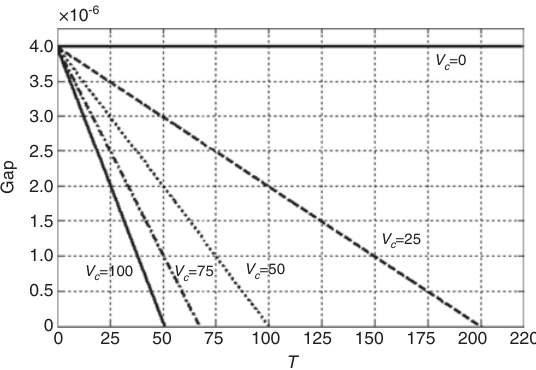
Figure 6 Variation of the gap at the FGM microgripper beam free ends for different ceramic percentage due to the temperature